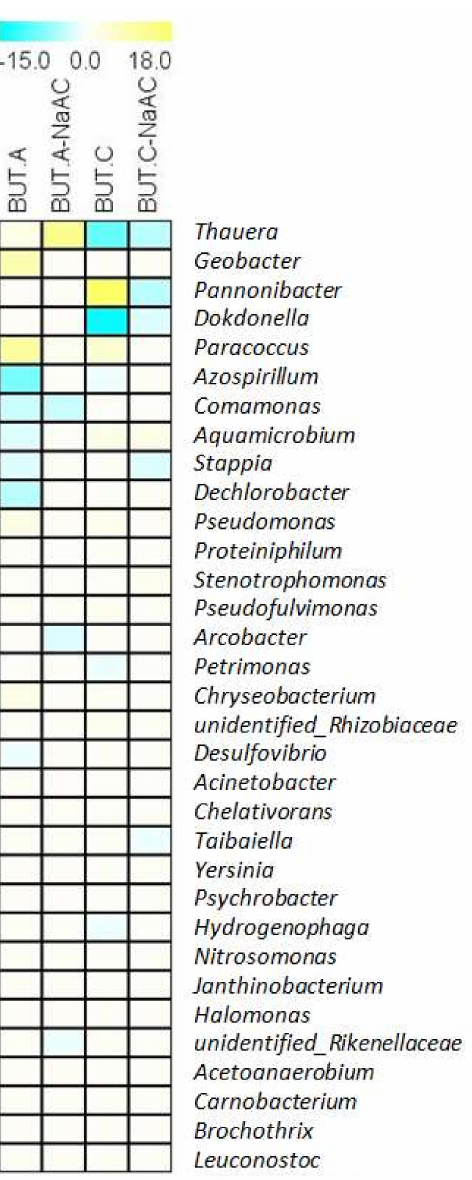
Figure 4. The 33 genera relative abundances (%) on the anode (A) and cathode (C) of MFCs; the values are represented in color as the di ff erence between BUT treatment and control. Data are shown for when absolute values were greater than one. The values of controls are shown in Table S3 (Supplementary